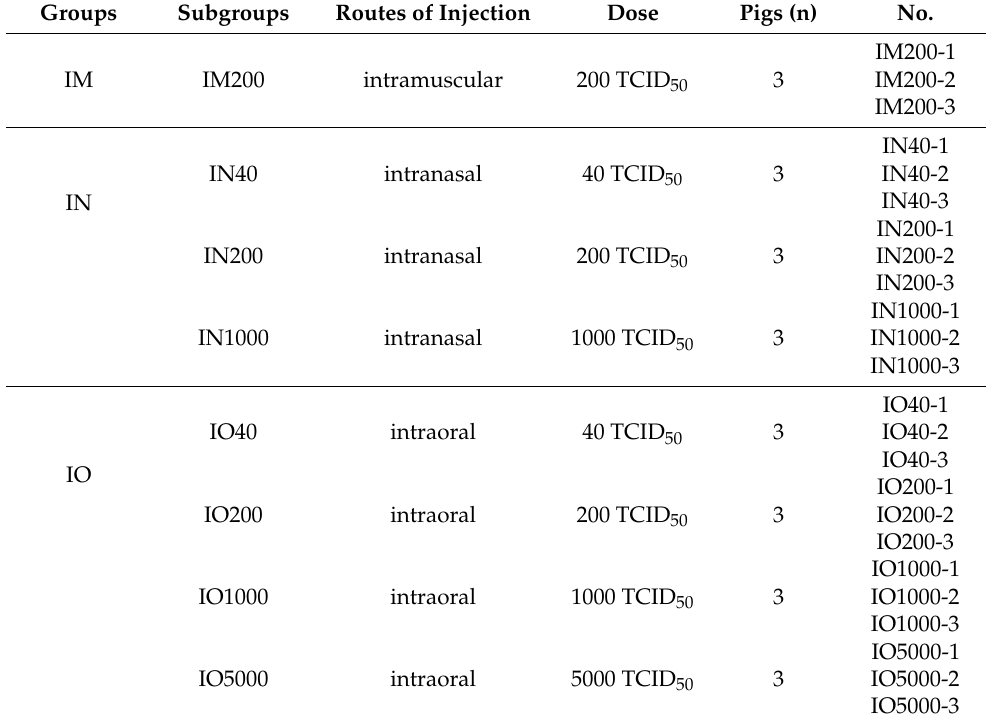
Table 1. Experimental groups.